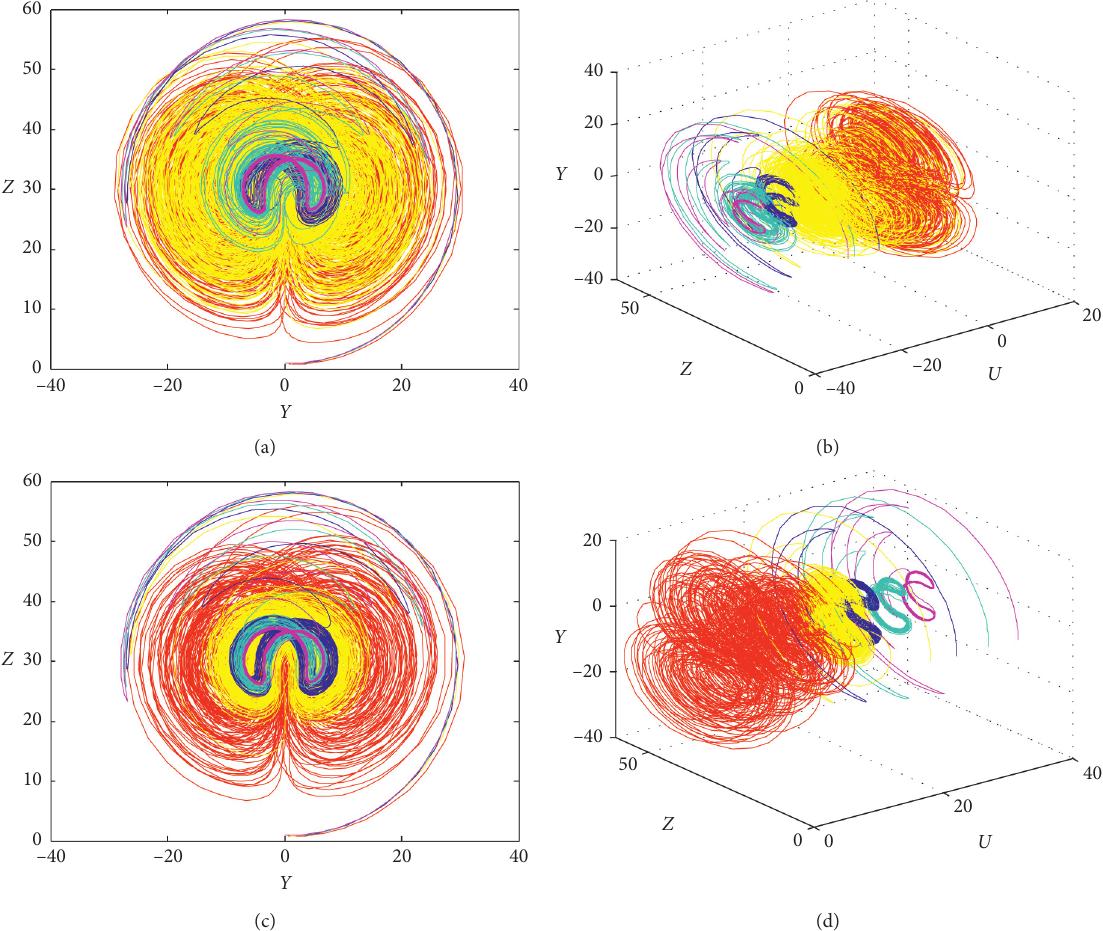
Figure 6: The phase portraits of the occurrence of infinitely many hidden attractors in the Y - Z plane and the Y - Z - U space with different negative and positive U (0). (a), (b) U (0) �− 7 (red), hyperchaos; U (0) � − 20.5 (yellow), chaos; U (0) �− 24.5 (blue) or U (0) �− 30 (cyan), asymmetrical limit cycle; U (0) � − 31.5 (magenta), symmetrical limit cycle. (c), (d) U (0) � 5 (red), hyperchaos; U (0) � 18.5 (yellow), chaos; U (0) � 22.5 (blue) or U (0) � 27.5 (cyan), asymmetrical limit cycle; U (0) � 32 (magenta), symmetrical limit